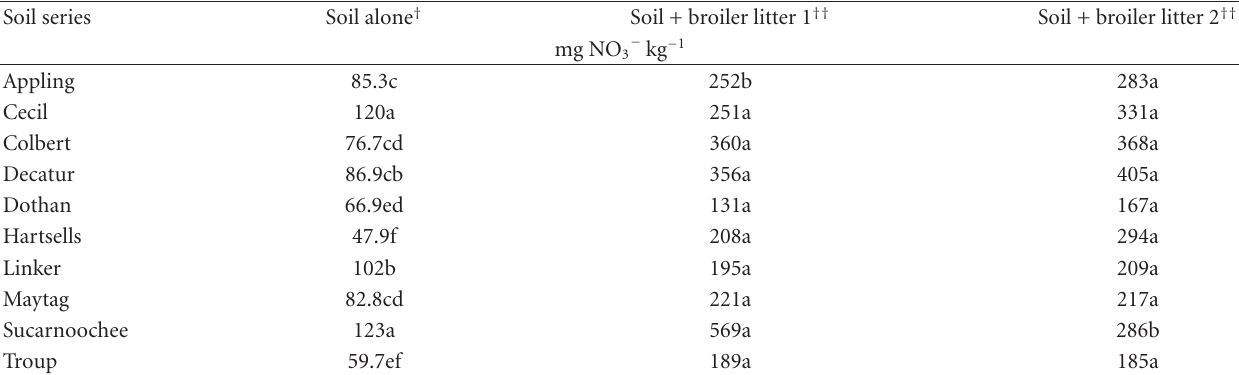
Table 5: Comparison of calculated potentially mineralizable organic N pools ( N 0 ) in soils alone and soils amended with broiler litter 1 or 2. Soil series